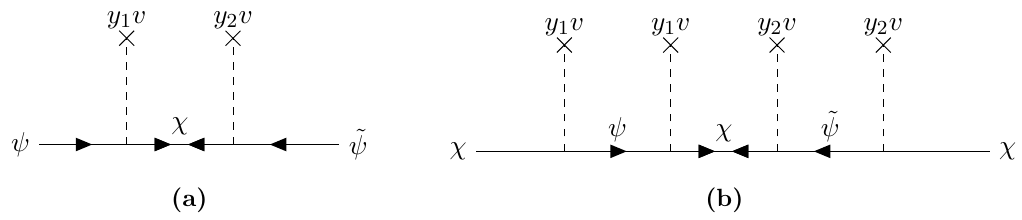
Figure 3. Contributions to mass splitting within n-plets for m M